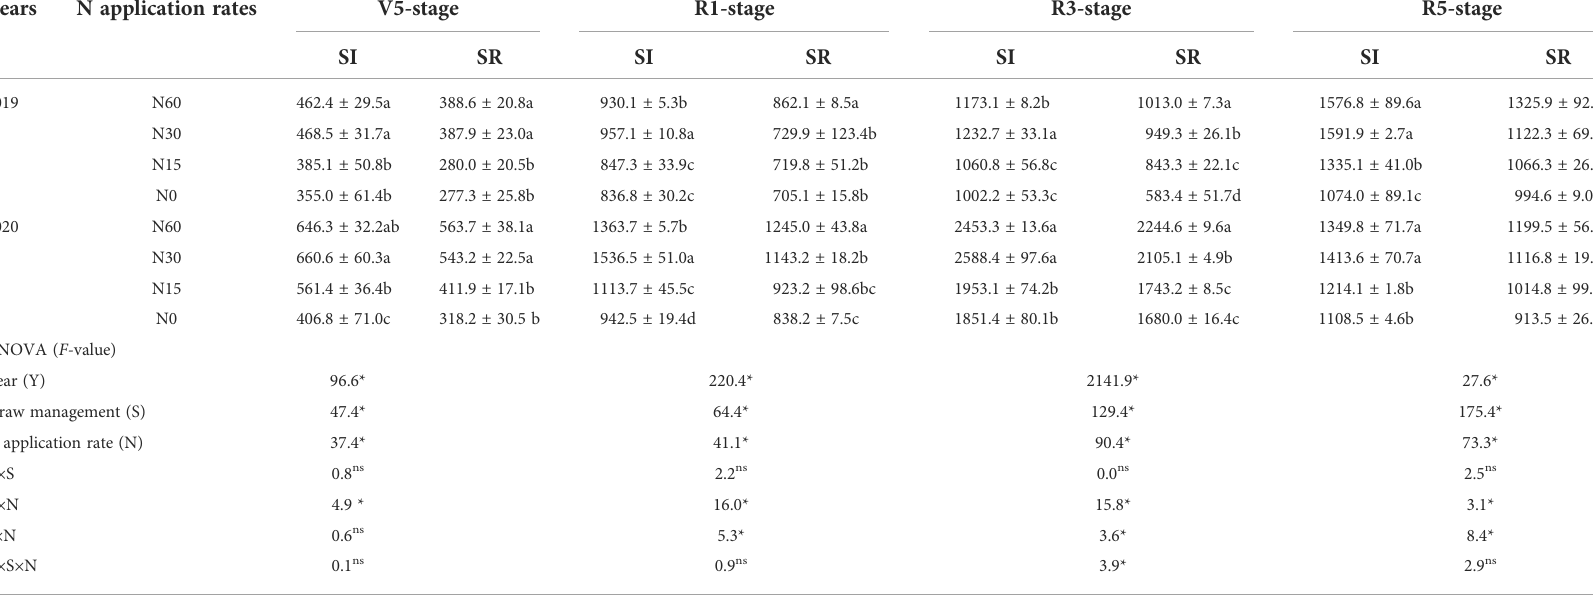
TABLE 2 Effects of straw incorporation and nitrogen application on root length of intercropped soybean at different growth stages (cm plant -1